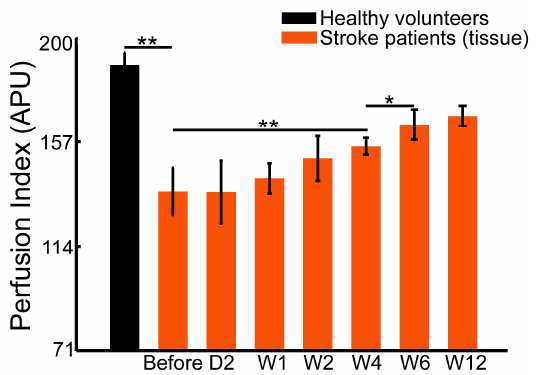
Figure 5. Tissue perfusion signals in healthy volunteers and patients at different stages of rehabilitation (* p < 0.05; ** p < 0.01).